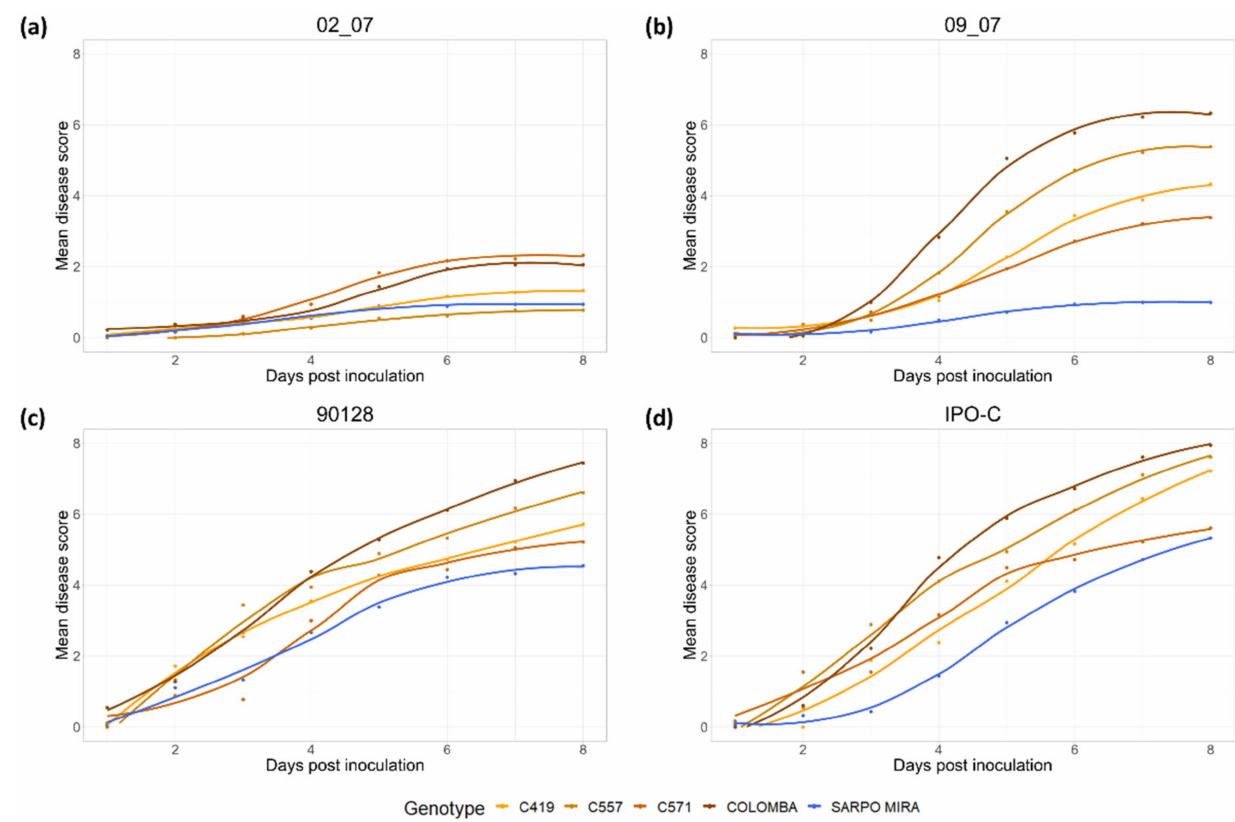
Figure 5. Late blight disease progression curves of the Colomba cross group show intermediate resistance of the progeny R8 genotypes compared to parental potato cultivars, after inoculation with Phytophthora infestans isolate 02_07 ( a ), isolate 09_07 ( b ), isolate 90128 ( c ), and isolate IPO-C ( d ). Genotype C571 is the only progeny that shows comparable disease resistance to S á rpo Mira, both after inoculation with isolate IPO-C and 90128. Genotypes C419 and C557 show milder symptoms compared to the susceptible parental cultivar Colomba, after inoculation with isolates 09_07, 90128, and IPO-C. All three genotypes and parental cultivars are resistant to isolate